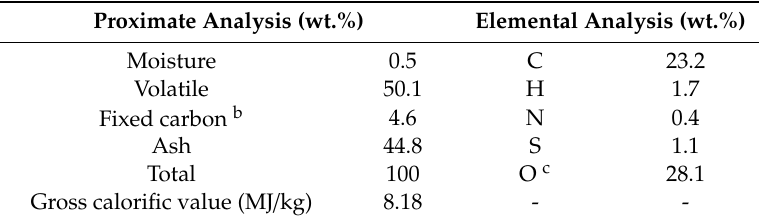
Table 1. Proximate and elemental analysis of Omari oil shale samples a . Proximate Analysis